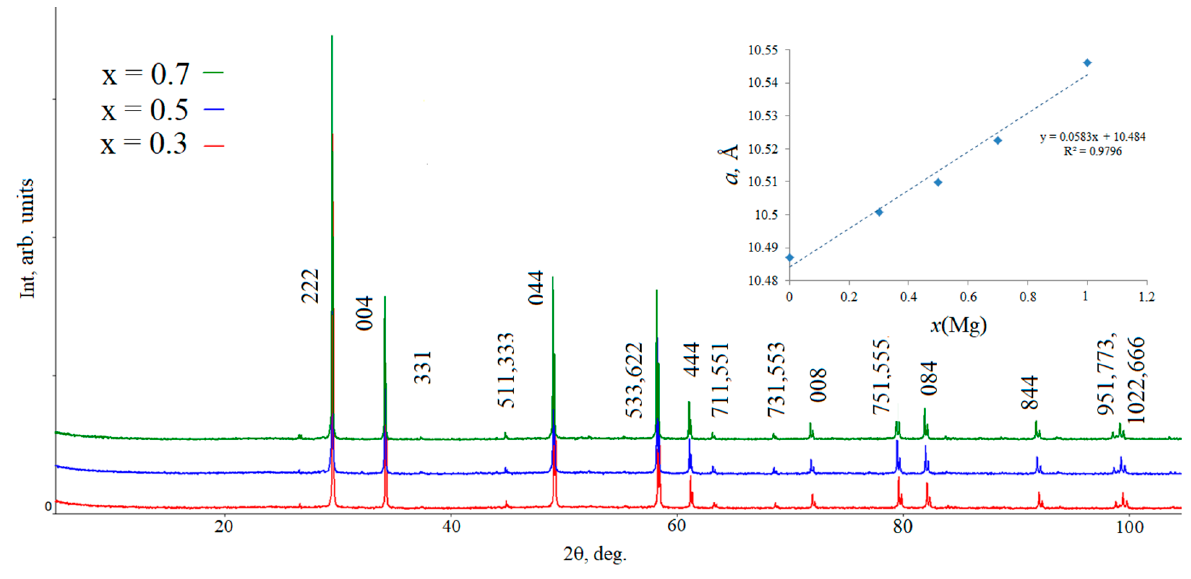
Figure 1. XRD patterns and dependence of the unit cell parameter on the content of magnesium ions of Bi 2 Mg x Fe 1-x Ta 2 O 9.5- Δ (x = 0.3, 0.5, 0.7). of Bi 2 Mg x Fe 1 − x Ta 2 O 9.5 − ∆ (x = 0.3, 0.5,